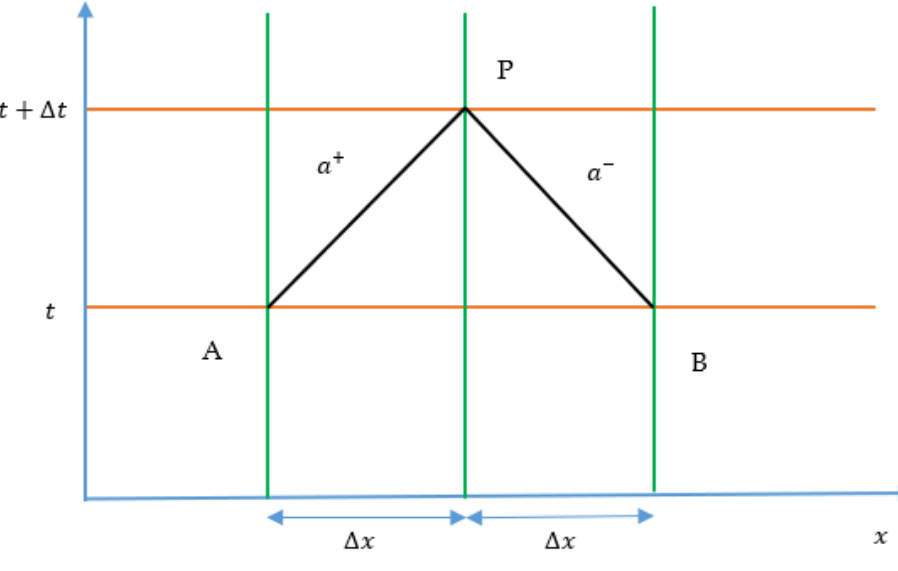
Figure 2. Characteristic lines in the 𝑥 − 𝑡 plan [3,18].